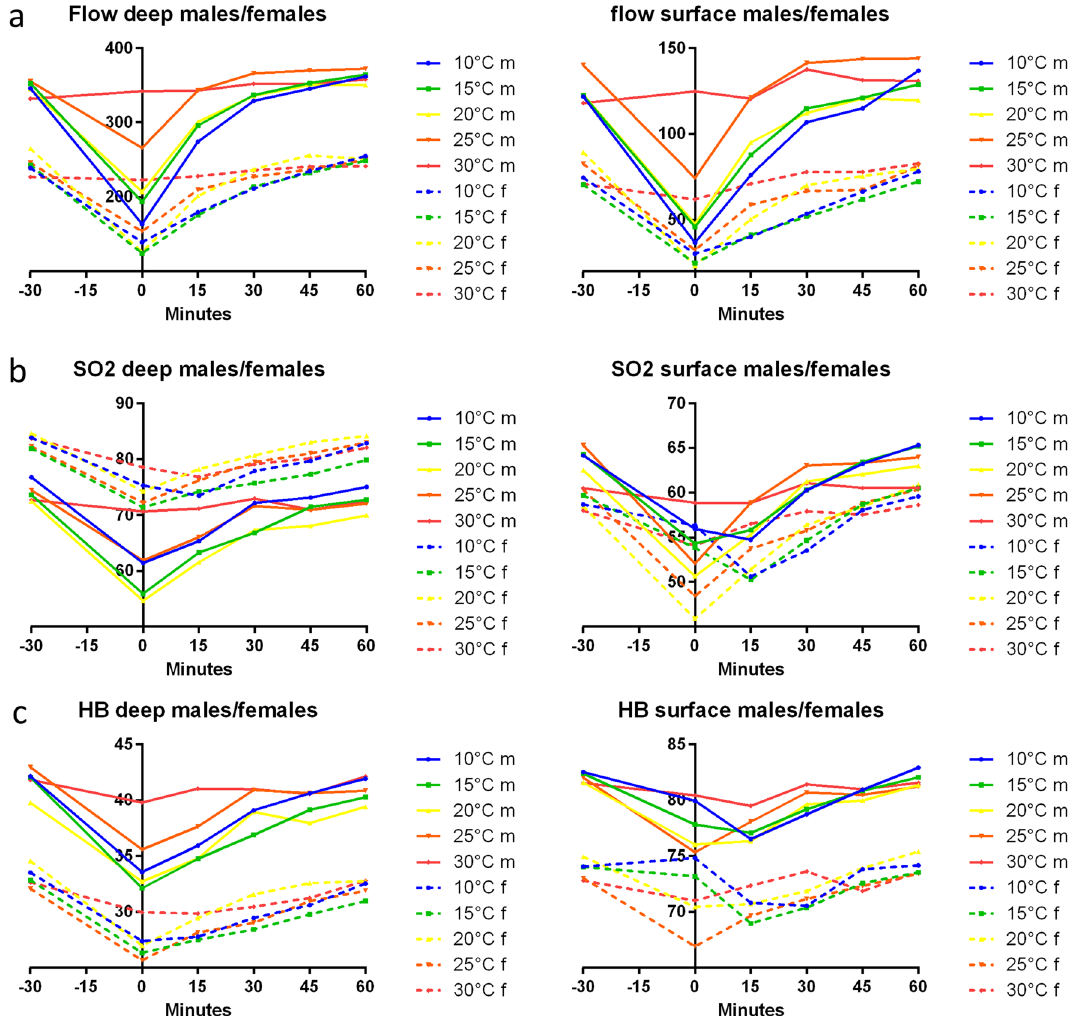
Figure 2. Progress of measured values before and after cooling: ( a ) surface and deep tissue blood flow [AU] in females/males, ( b ) surface and deep tissue oxygen saturation [%] in females/males, ( c ) surface and deep tissue haemoglobin concentration [AU] in